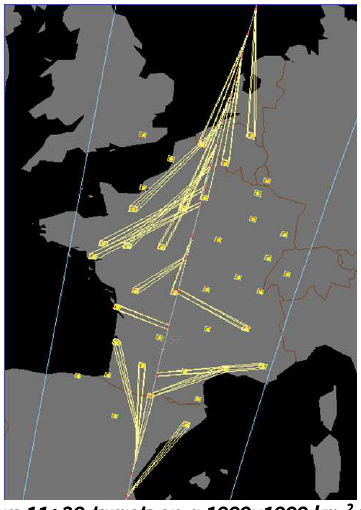
Figure 11: 20 targets on a 1000x1000 km² area